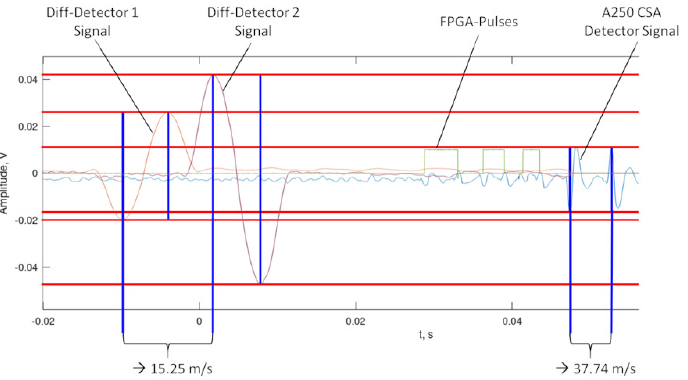
Figure 10. Preliminary test results of the linac stage. The particle speed is measured by the flight time between the first and third tube in the differential detector (15.25 m/s) and a single end detector after the linac stage (37.47